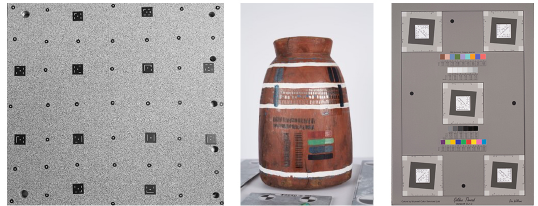
Figure 1. Panel target (left); Mango Vase (centre); DICE target (right). The Panel target, is an aluminium plate (30.5 x 30 x 0.8 cm) coated with a pseudo-random pattern optimised for the optical detection of surface strain in engineered surfaces with Digital Image Correlation (Sargeant et al., 2016). The pseudo-random pattern has a high local contrast and small features, which are optimised to increase the sensitivity and practicality of image matching